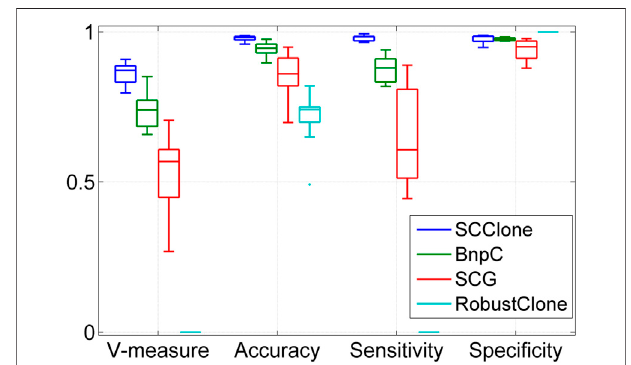
FIGURE3| PerformanceevaluationresultsonthesimulateddatasetD3. Thedatasetconsistsof1,000×500genotypematriceswiththefalsenegative rate being as high as 0.8.